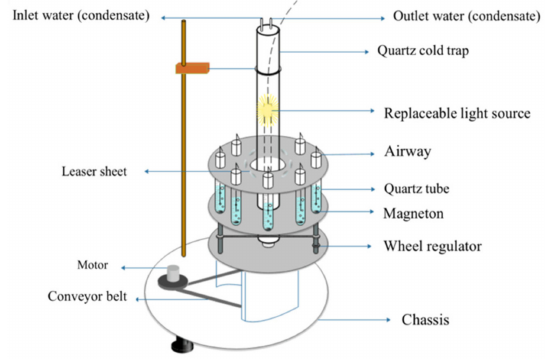
Figure 2. Reaction device for photocatalytic reduction of CO 2